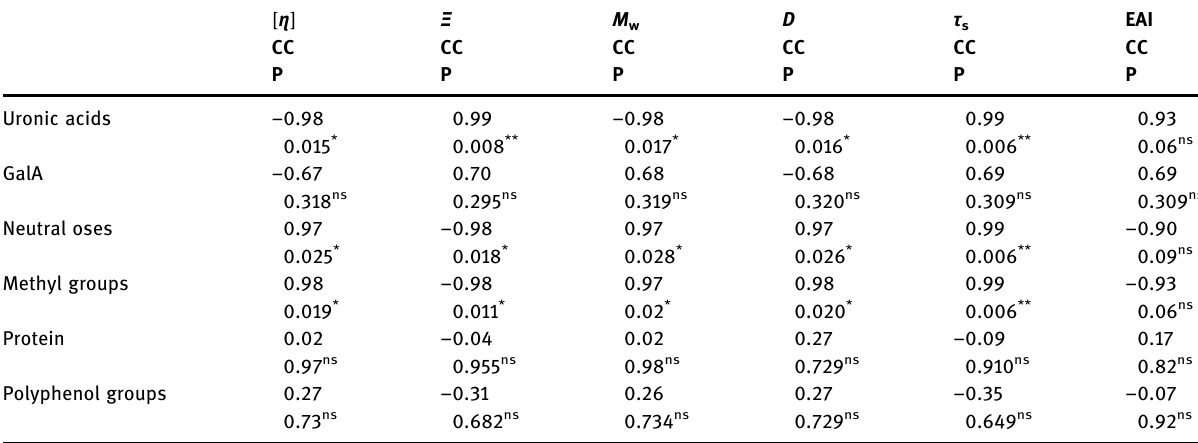
Table 6: Correlation between composition and physicochemical, rheological, and emulsifying properties of extracted